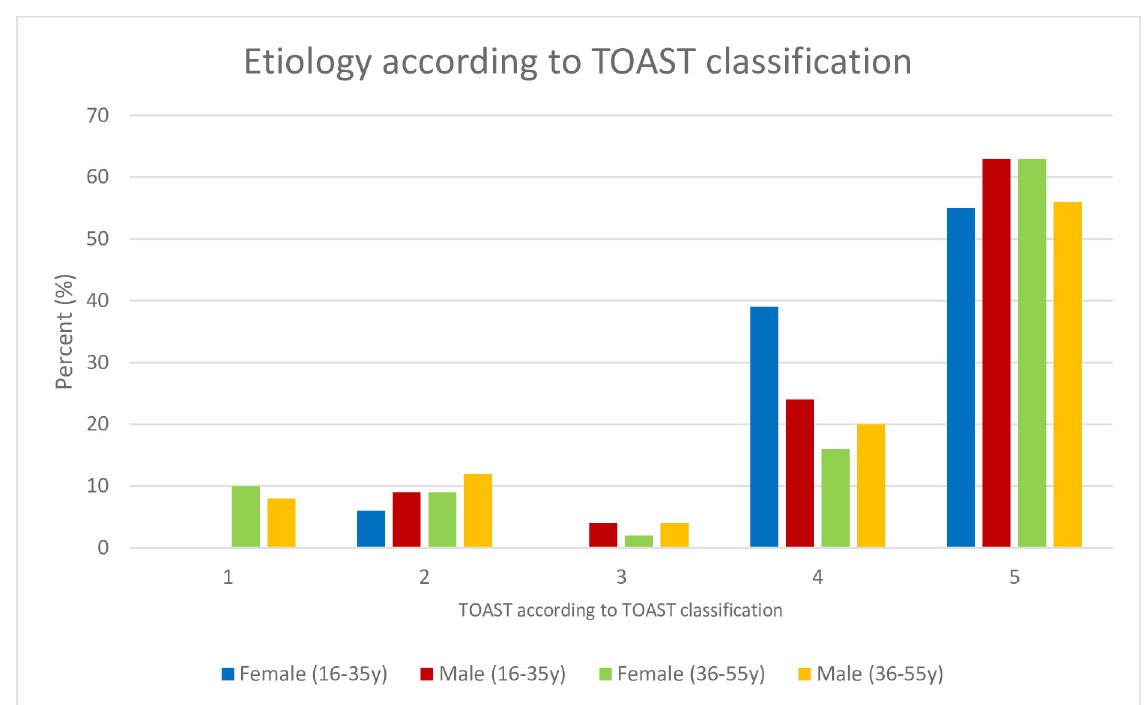
Fig 2. Y indicates years. 1: Large artery atherosclerosis/macroangiopathy. 2: Cardiac embolism. 3: Small vessel disease/microangiopathies. 4: Other determined etiology. 5. Undetermined etiology, including undetermined despite complete evaluation, undetermined without complete evaluation and multiple possible